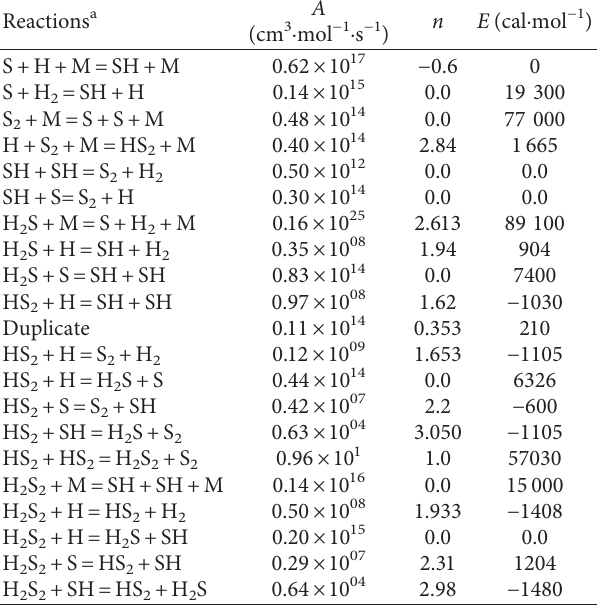
Table 1: The kinetic parameters for the pyrolysis of H